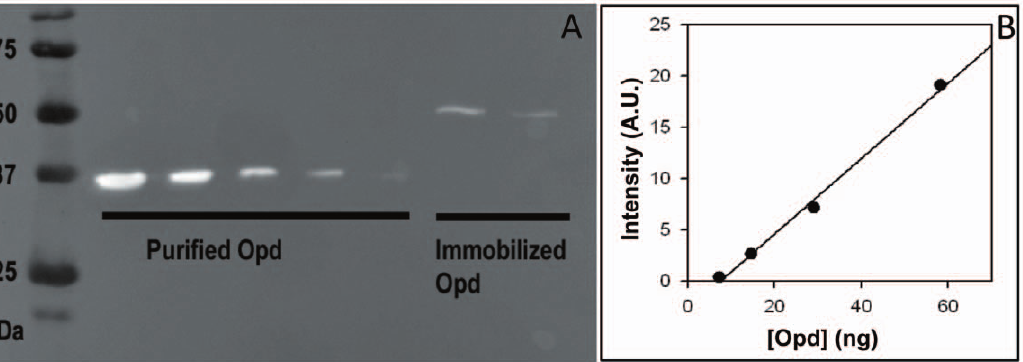
Figure 3. MamC-Opd assay in the magnetosome sample. (a) Western blot assay of purified and immobilized Opd. The purified protein deposits are 117, 58, 29, 15 and 7 ng, from left to right. The magnetosome membrane was dissolved in 4% SDS and two deposits of solubilized membrane proteins were made (15 and 10 m l). Expected molecular weights for Opd and MamC-Opd are 34.6 and 49.6 kDa respectively. (b) Calibration curve for Opd quantification obtained with GeneTools image analysis software from Syngene. The computed Opd quantities in the solubilized magnetosome membrane proteins are 17.3 and 9.6 ng for the 15 and 10 m l of solubilized magnetosome membrane protein deposits (from left to right).